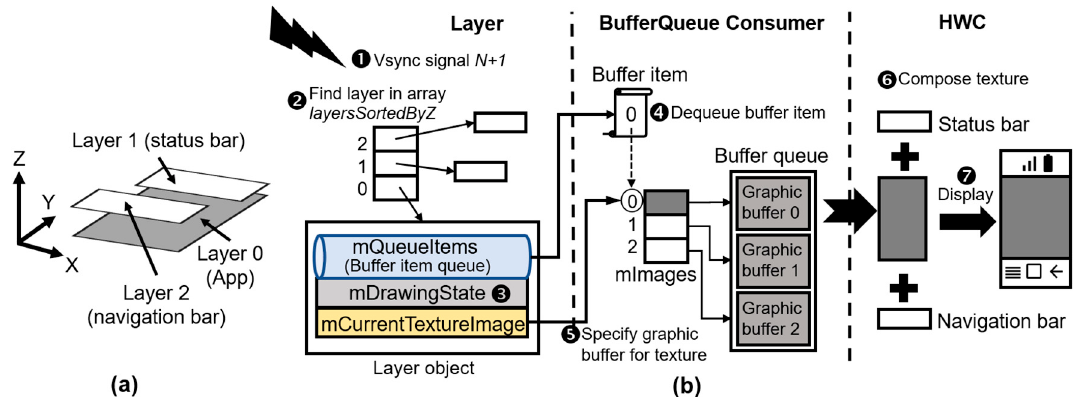
Figure 2. Frame display process of SurfaceFlinger: ( a ) layers; ( b ) frame display flow.